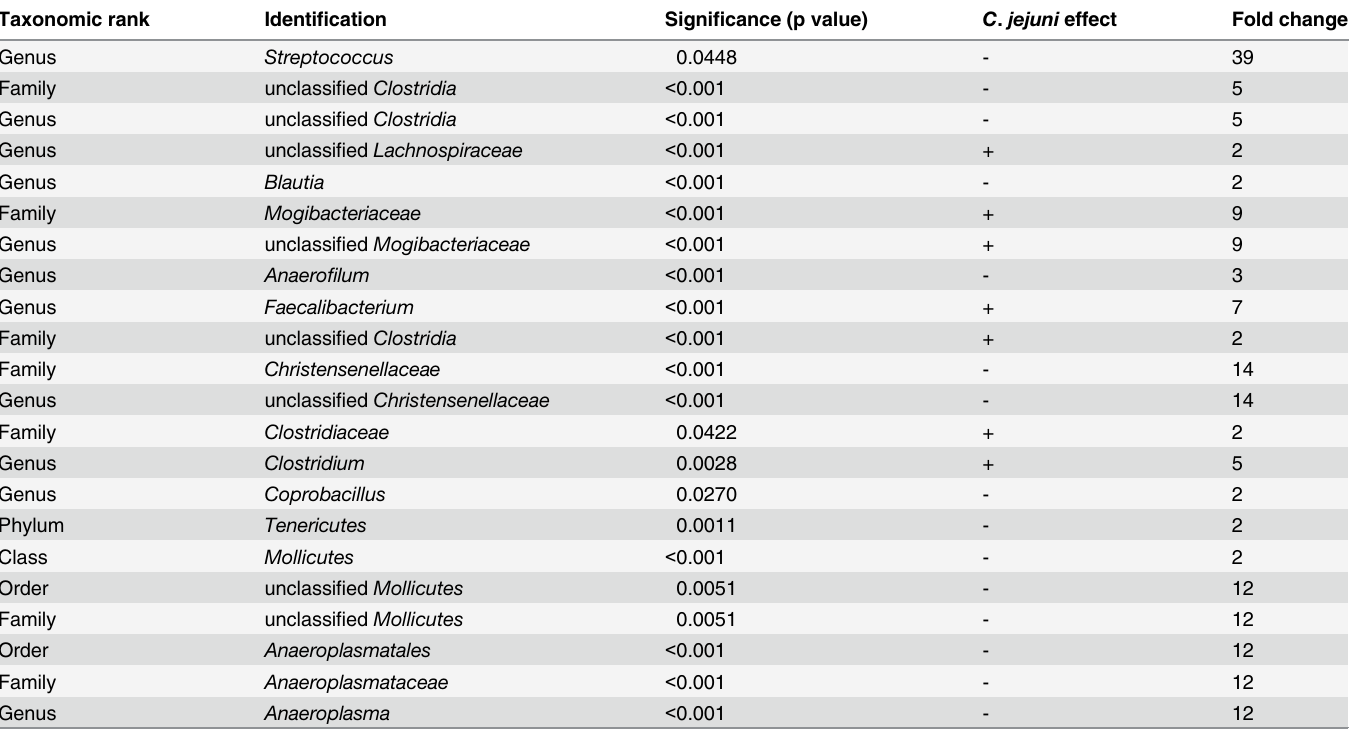
Table 3. Changes in the relative abundance of the caecal microbiome phylum induced by C . jejuni colonization. Taxonomic